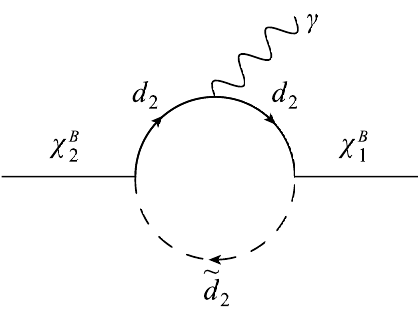
Figure 17. Example of diagram contributing to the decay of (cid:31) B